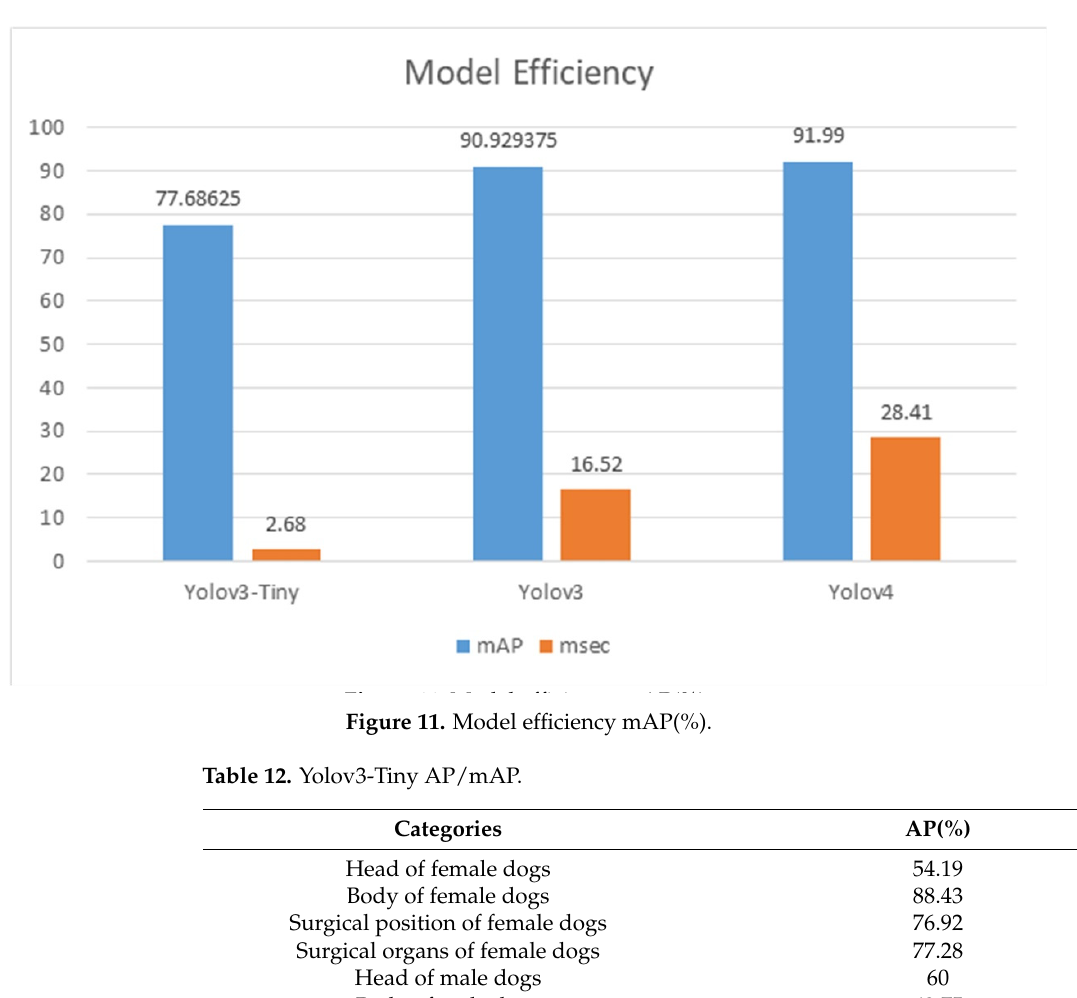
Table 11. Model efficiency.